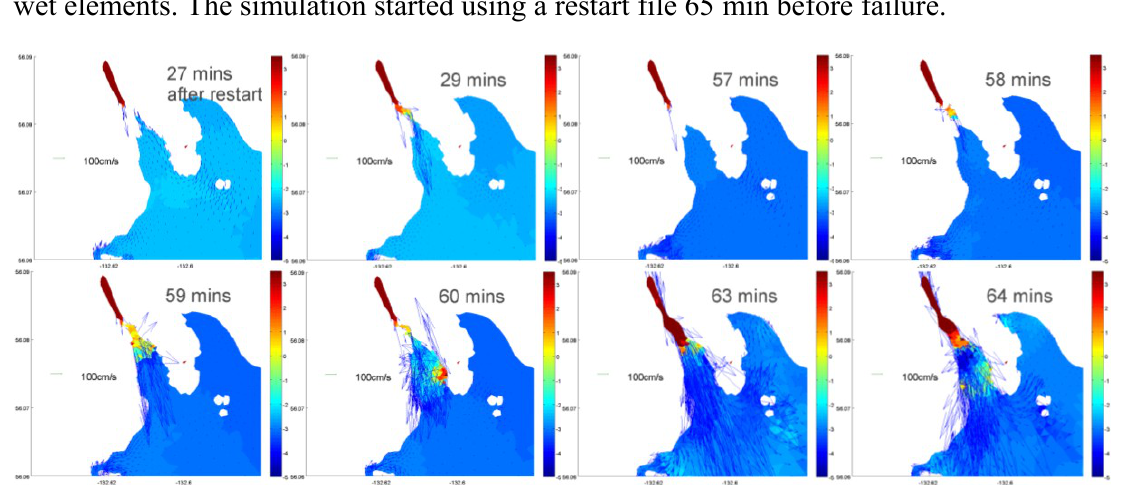
Figure 6. Time sequence of the modeled elevation and velocity field around landlocked wet elements. The simulation started using a restart file 65 min before